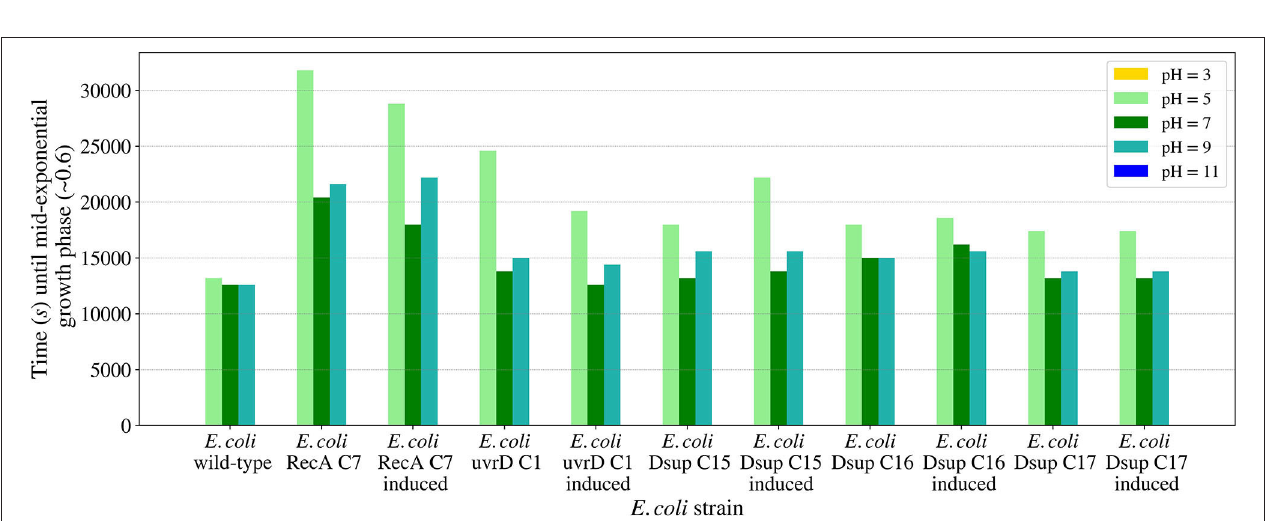
FIGURE 11 | Time needed for the E. coli wild-type and the selected colonies of the RecA, uvrD, and Dsup strains to reach mid-exponential growth phase (OD 600nm ∼ 0.6) when inoculated in LB media with different pH values. The effects of the gene products were tested with and without induction to detect any possible effects on cellular